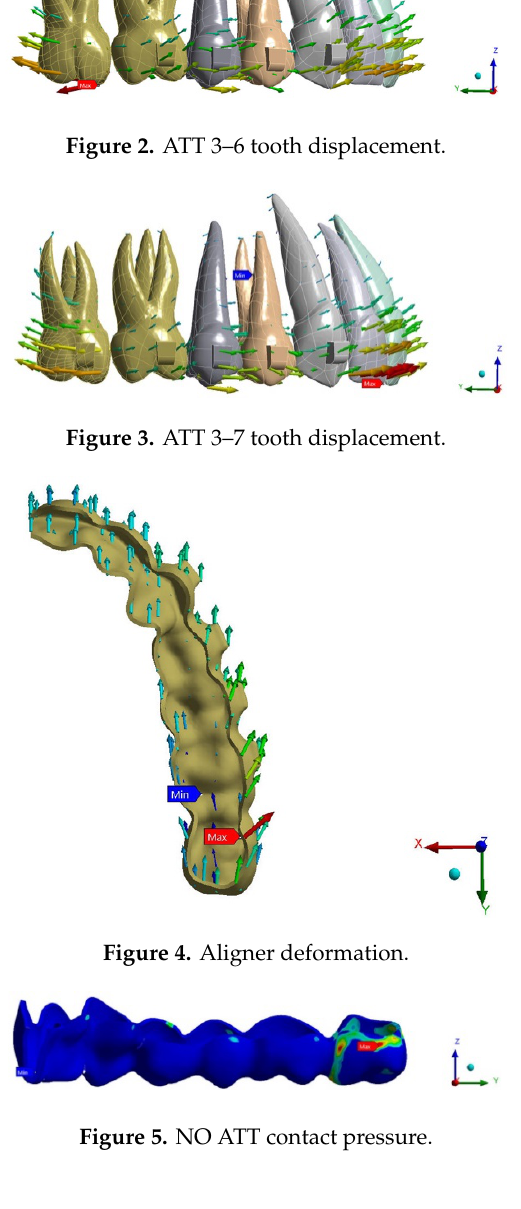
Figure 6. ATT 3–6 contact pressure.